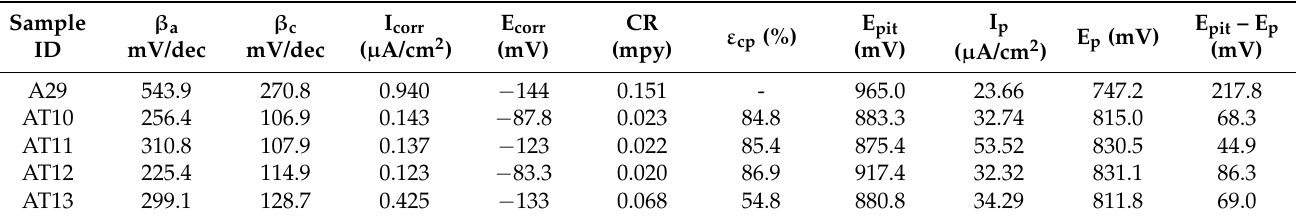
Table 6. Tafel extrapolation and pitting parameters obtained from the CPDP measurement for the samples heat-treated at different solutionizing temperatures